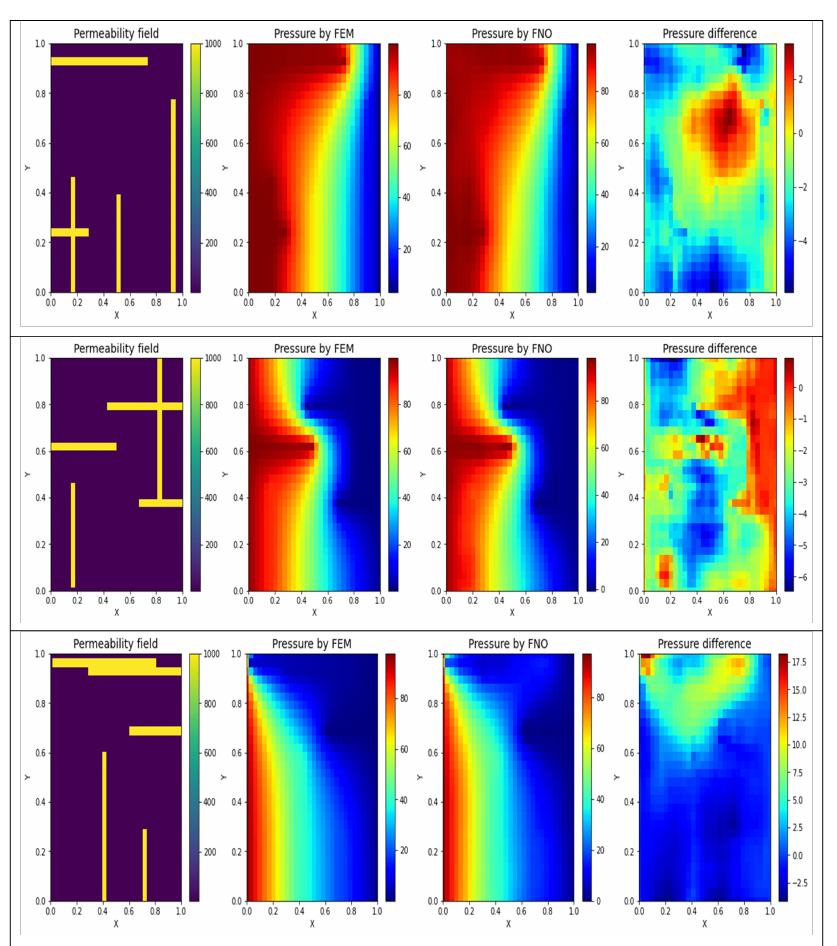
Figure 5. A comparison between the actual pressure distributions and those obtained by FNO for three representative testing subset samples. The pressure difference is based on a point-by-point absolute error. Outputs are displayed as rectangles rather than squares due to a scaling